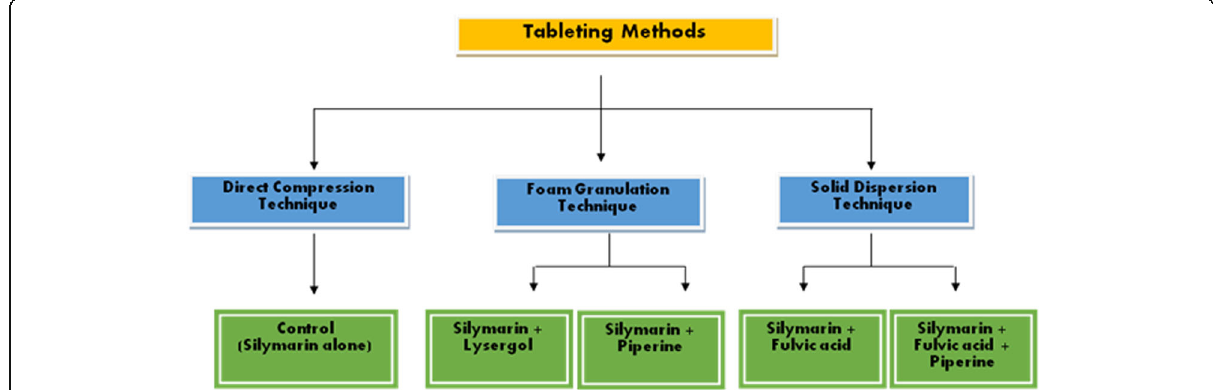
Fig. 4 Various tablet manufacturing techniques employed for the formulation of different combinations of silymarin and